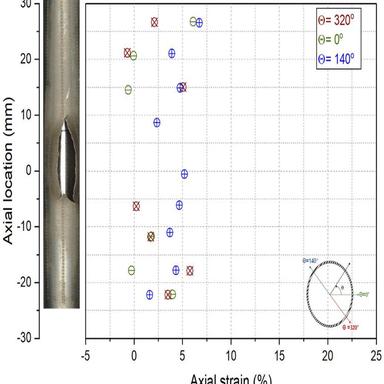
Permanent axial strain distribution along the axial direction at three different orientations.